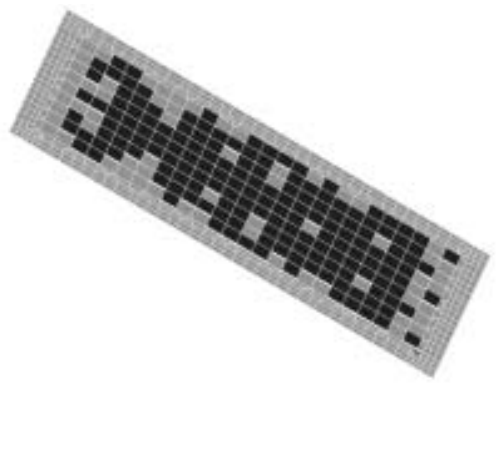
Fig. 8. Optimized panel’s F.E.